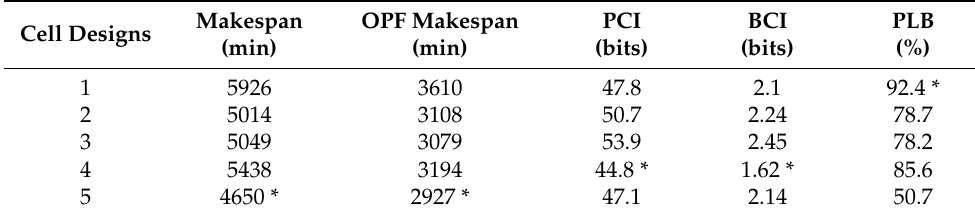
Table 2. Enumerated results of all the criteria and sub-criteria.